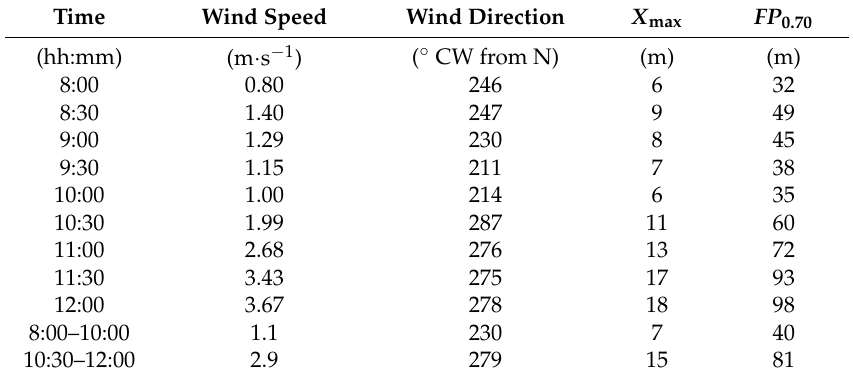
Table 1. Half hour values of wind speed and direction (2nd and 3rd columns), X max (4th column), FP0.70 (5th column), from 8:00 a.m. to 12:00 p.m. during the image acquisition day. Average